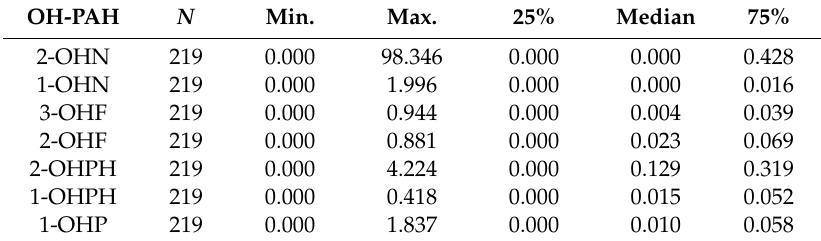
Table 3. The average concentrations of seven OH-PAHs ( μ g/L).